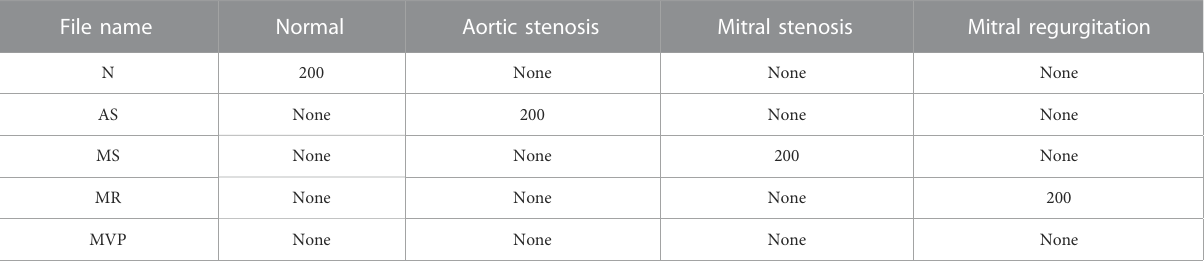
TABLE 3 Yaseen dataset.